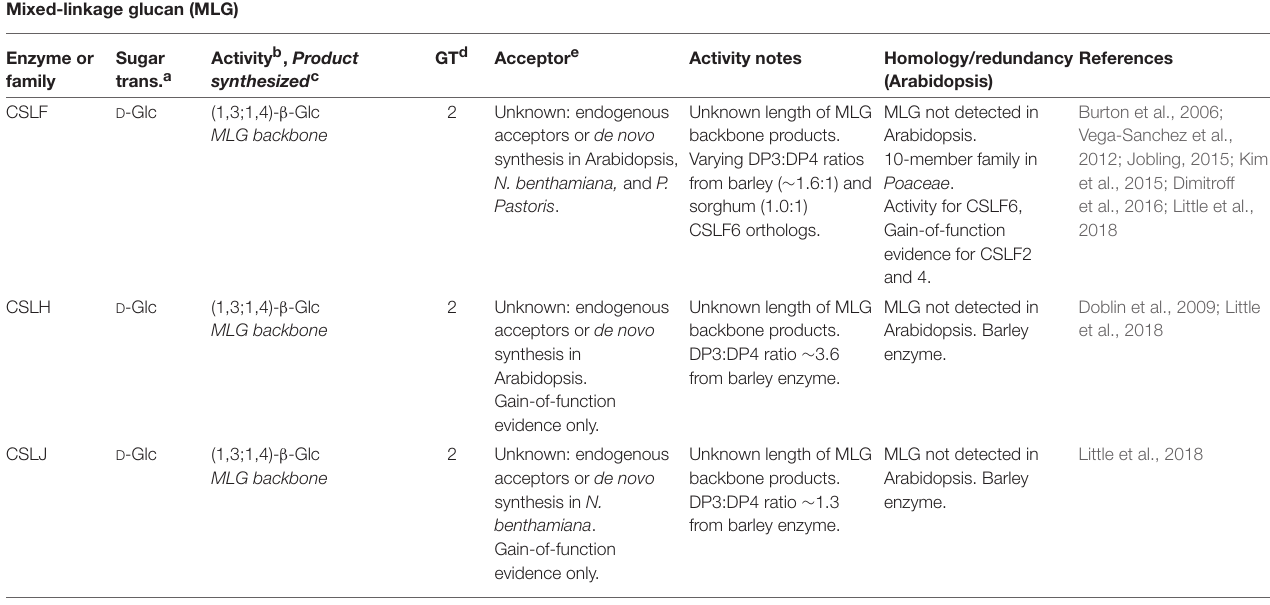
TABLE 4 | Mixed-linkage glucan biosynthetic GTs of known function determined by heterologous expression. Mixed-linkage glucan